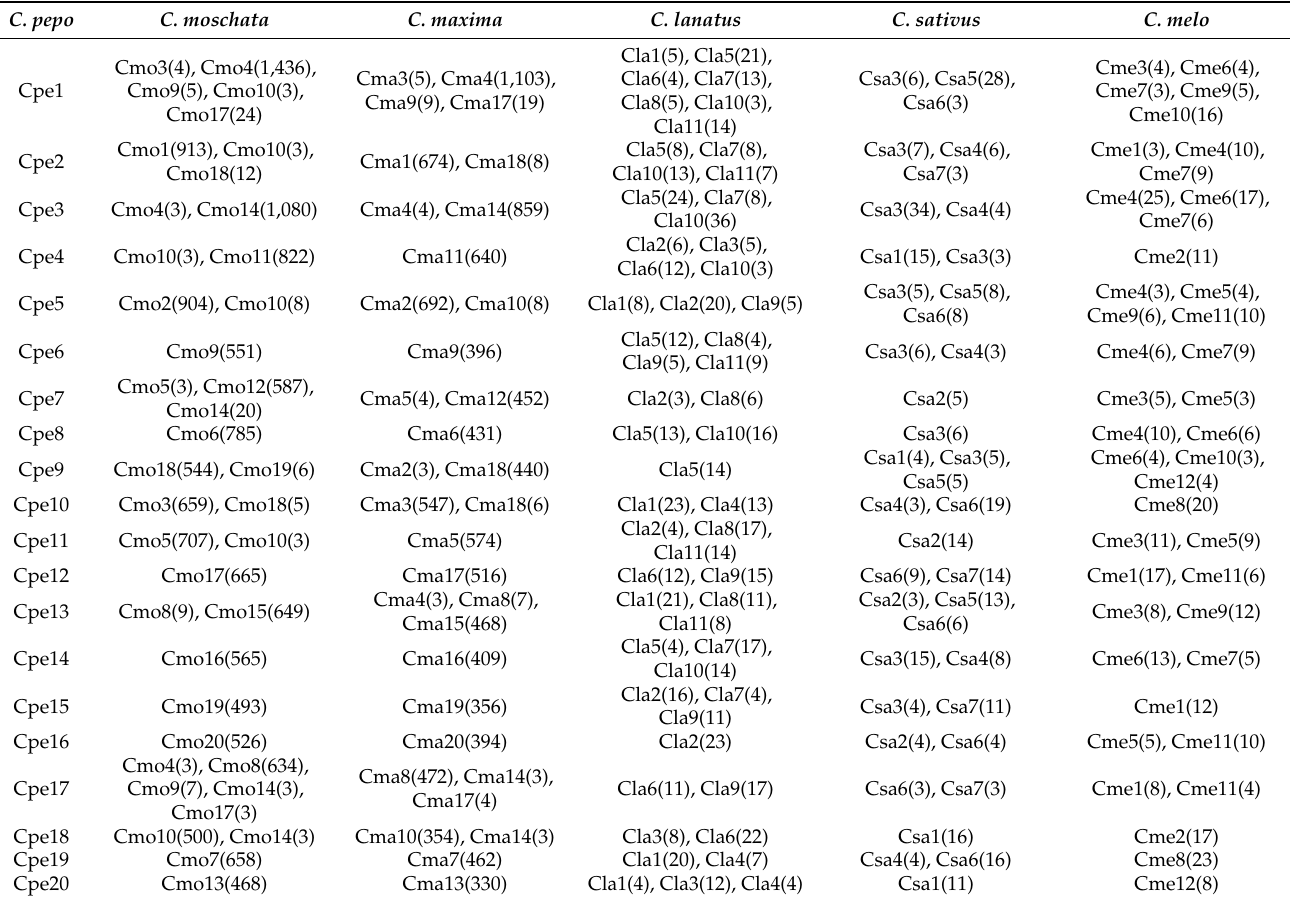
Table 1. The main syntenic relationships of C. pepo with other Cucurbitaceae